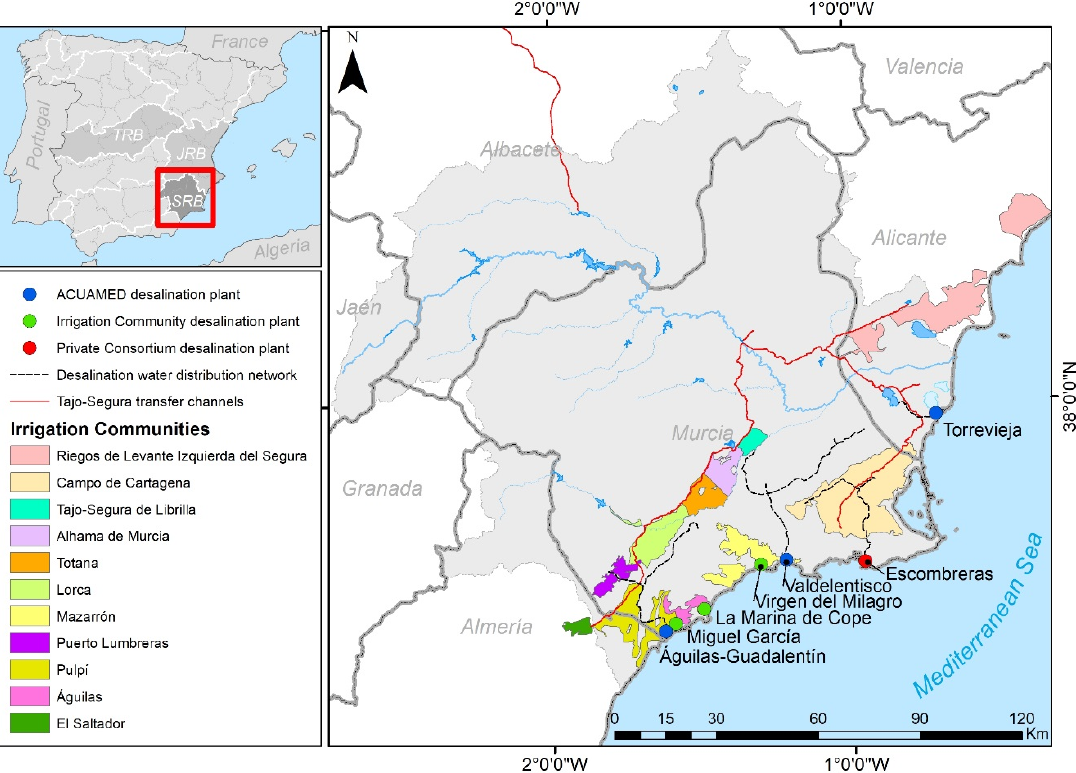
Figure 1. Irrigation communities surveyed, desalination plants according to owners, and the main water distribution network for irrigation uses in the Segura River Basin. Source: own elaboration from irrigation communities’ data.